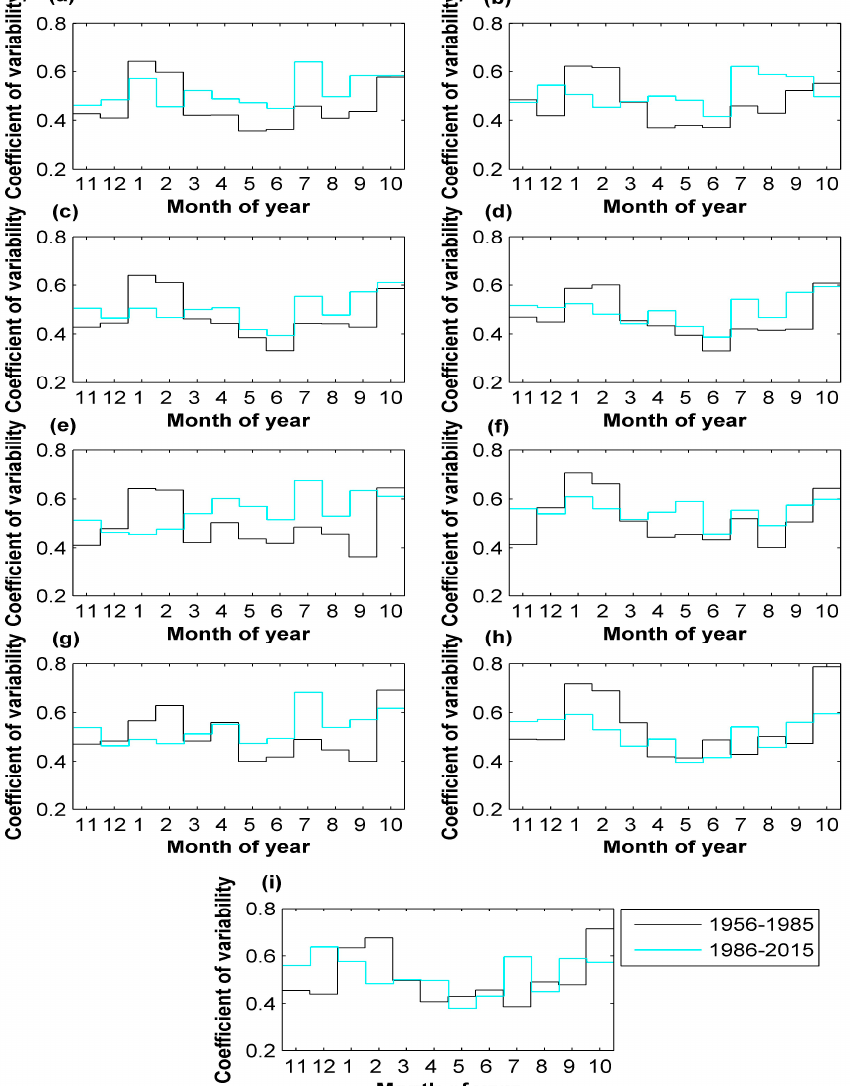
Figure 3. Variability of precipitation for two subsequent 30 ‐ year periods at ( a ) Ba ń ska Wy ż na; ( b